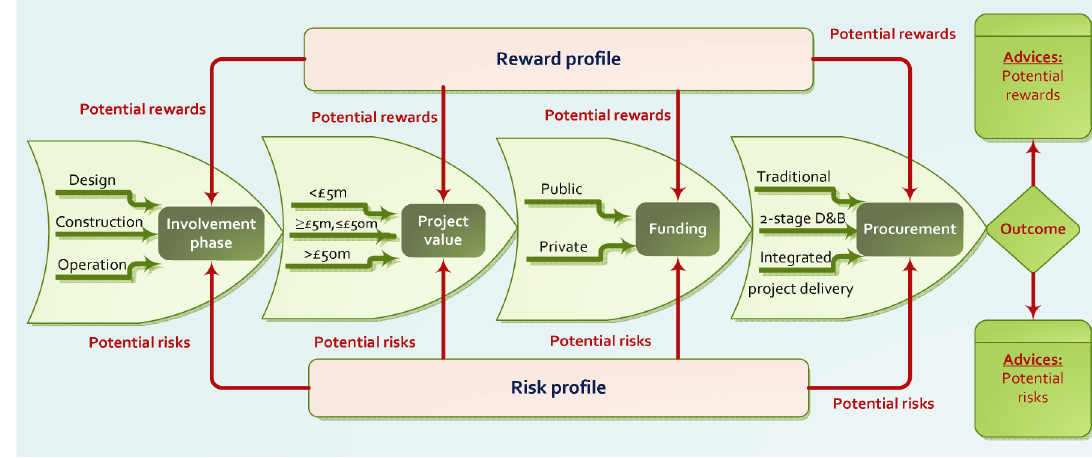
Fig. 1. Conceptual framework to help in the analysis of the risks and rewards of adopting BIM for